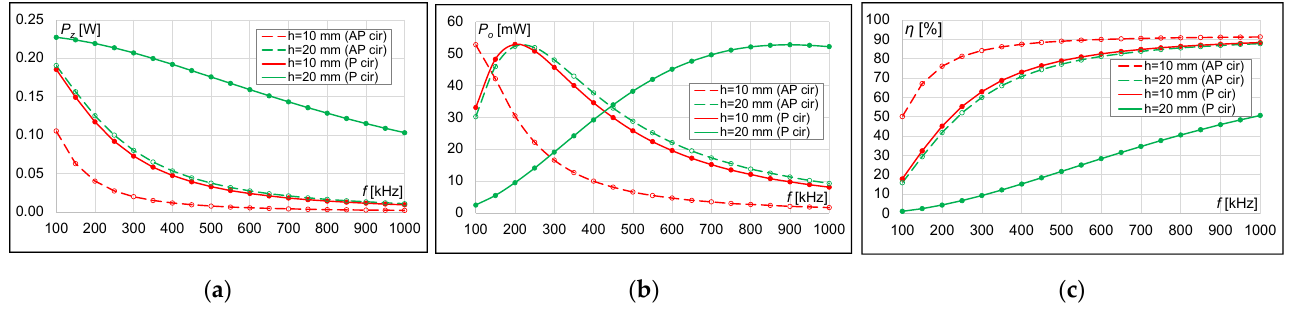
Figure 9. Results for circular coils with r = 20 mm and the number of turns n = 40 at two distances ( h = 10 mm and h = 20 mm): ( a ) transmitter power, ( b ) receiver power, ( c ) power transfer efficiency.